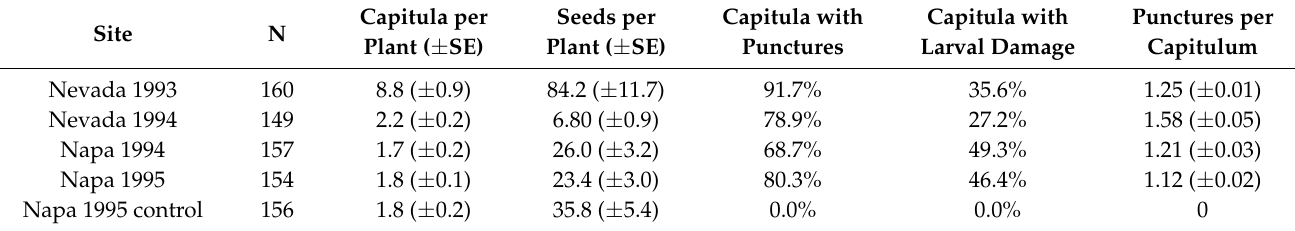
Table 5. Details of Centaurea solstitialis plants sampled along transects and levels of attack by Eustenopus villosus . N = number of plants sampled; Capitula with Punctures = percentage of the seasonal total of capitula with oviposition or feeding punctures; Capitula with Larval Damage = percentage of capitula with feeding damage from E. villosus larvae; Punctures per Capitulum = mean ( ± SE) number of oviposition and feeding punctures for capitula with at least on puncture. Capitula per Seeds per Capitula with Capitula with Punctures per Site N Plant ( ± SE) Plant ( ± SE) Punctures Larval Damage